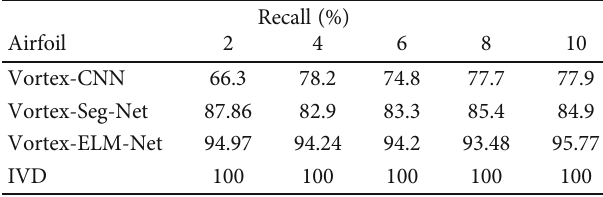
Table 4: Recall rate of Vortex-CNN, Vortex-Seg-Net, Vortex-ELM- Net, and IVD in airfoil fl ow fi eld with di ff erent attack angles.